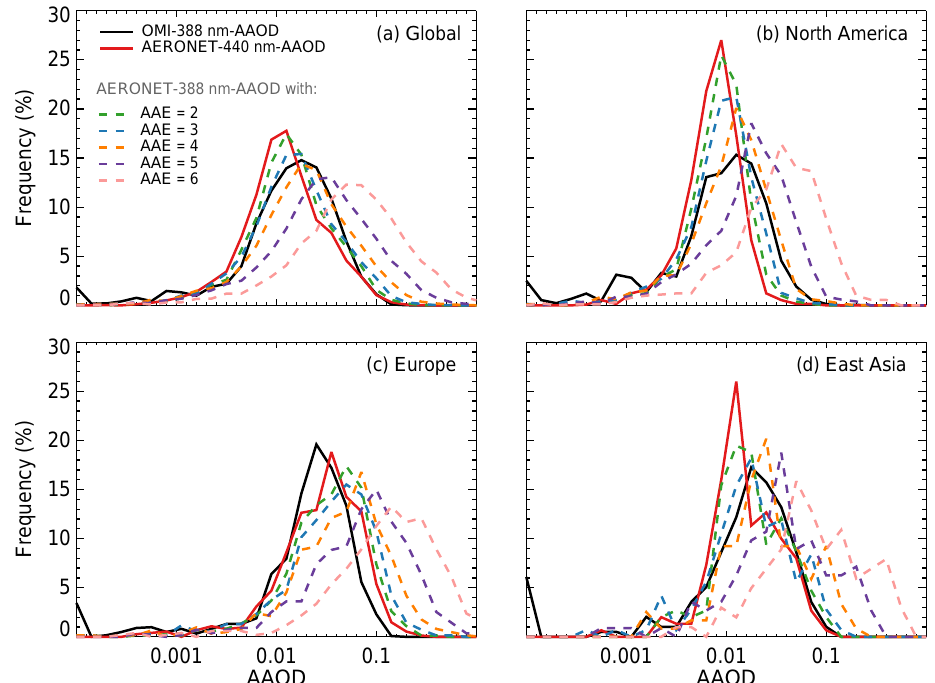
Figure 6. Frequency distributions of the AAOD measured by OMI at 388nm (black) and AERONET at 440nm (red), as well as AERONET observations adjusted to 388nm using a range of assumed AAE for BrC (dashed lines) for (a) the whole world, (b) North America, (c) Europe, and (d) East Asia. Details can be found in Sect.